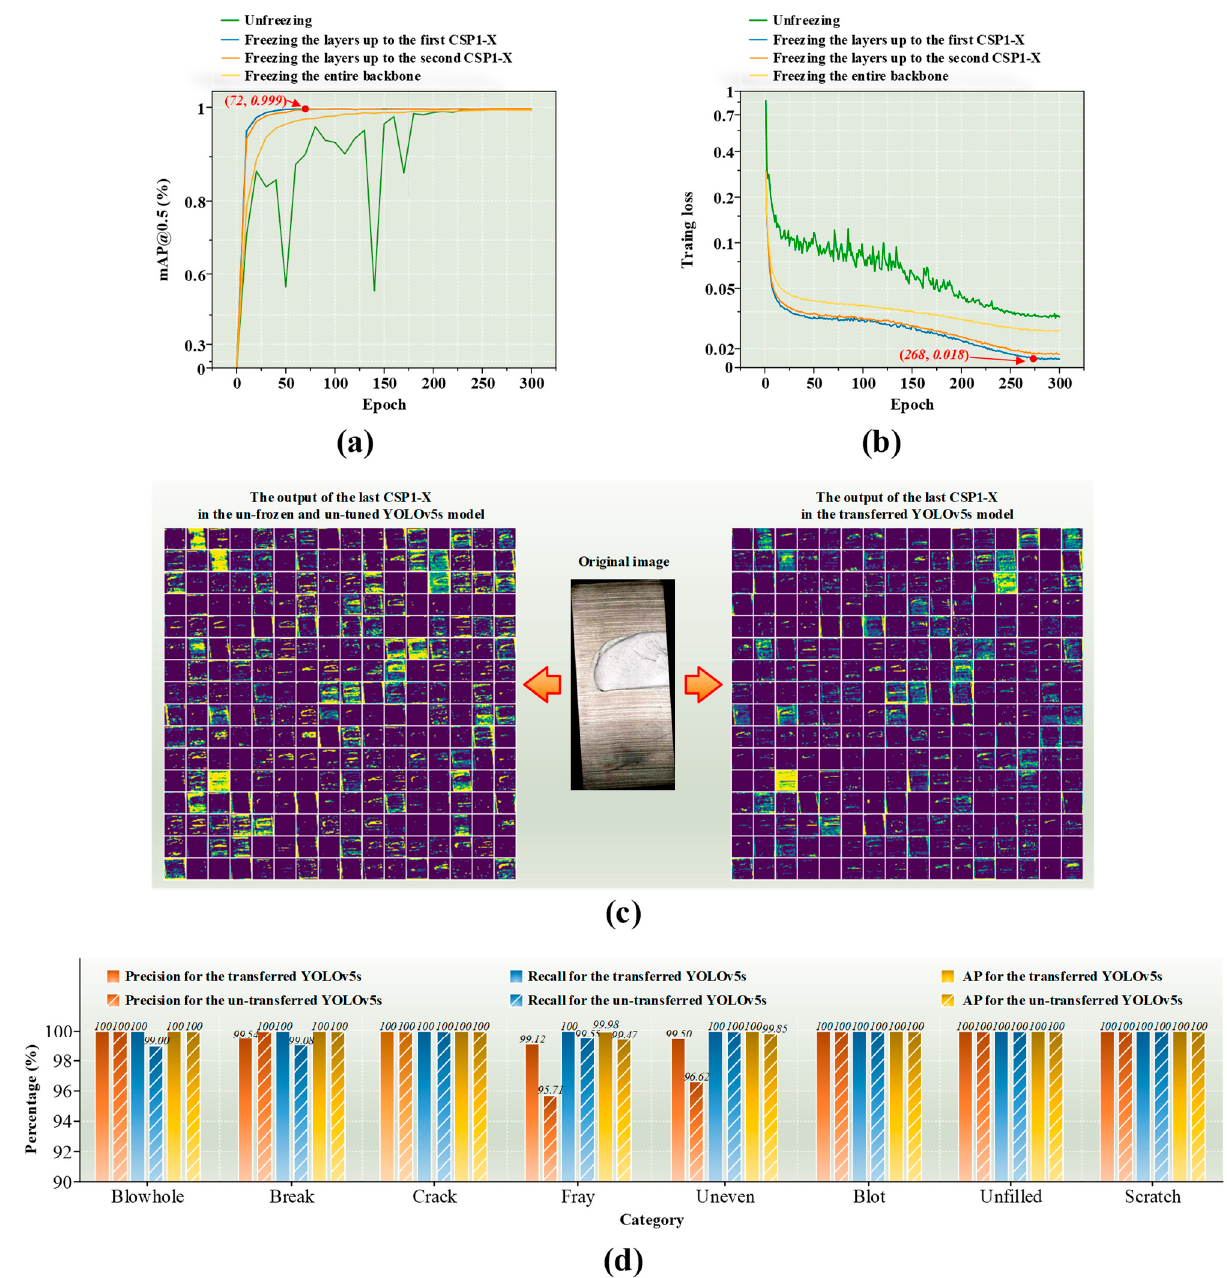
Figure 5. Transfer learning effects: ( a ) the mAP@0.5 result for different combinations of freezing and fine-tuning; ( b ) the training loss result for different combinations of freezing and fine-tuning; ( c ) the visualization difference of the output of the last CSP1-X in the backbone network between the un-frozen and un-tuned YOLOv5s model and the transferred YOLOv5s model; ( d ) results of the surface defect identification based on the transferred and un-transferred YOLOv5s.